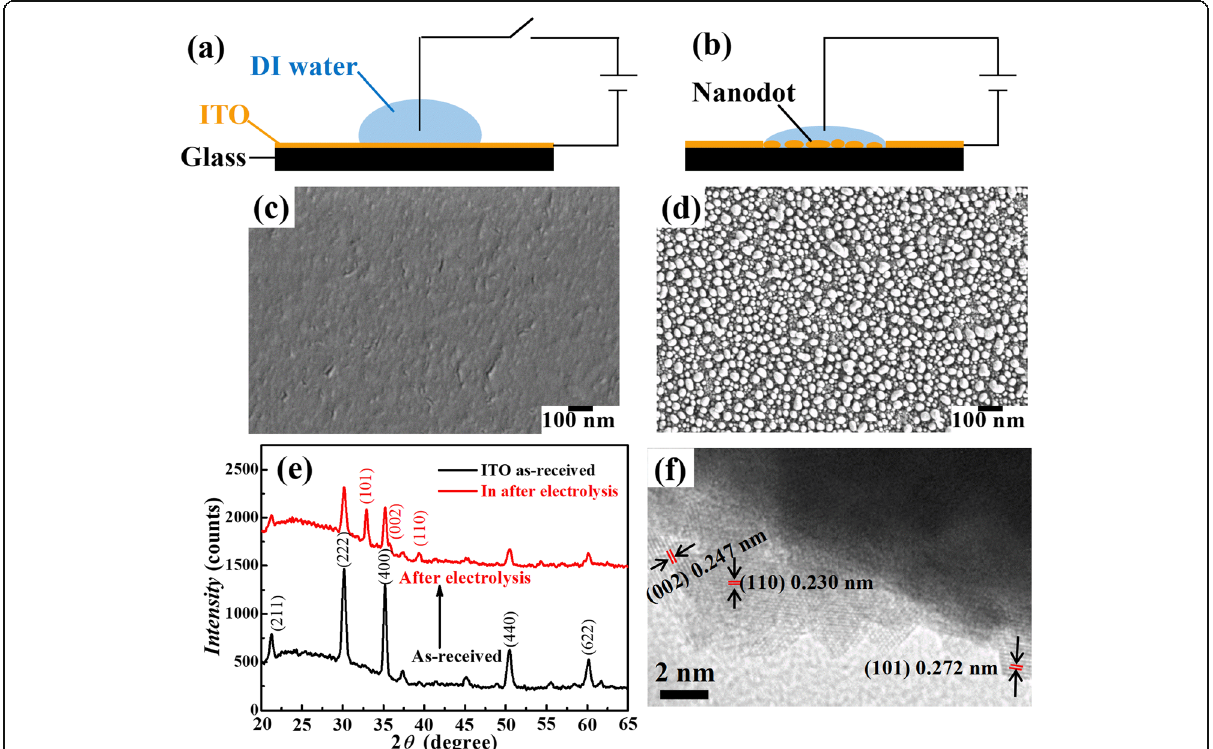
Fig. 1 Schematic of the In NDs formation from electrolysis of ITO film. a Initial state of a water droplet standing on an ITO film without applying a voltage. b Formation of NDs on the area covered with water when a voltage is applied. c SEM image of the intact ITO film surface corresponding to a . d SEM image of the formed NDs corresponding to b (applied voltage of 150 V for 1.5 min at ITO film thickness of 25 nm). e XRD spectra of the ITO film before and after electrolysis. f TEM image of the obtained In